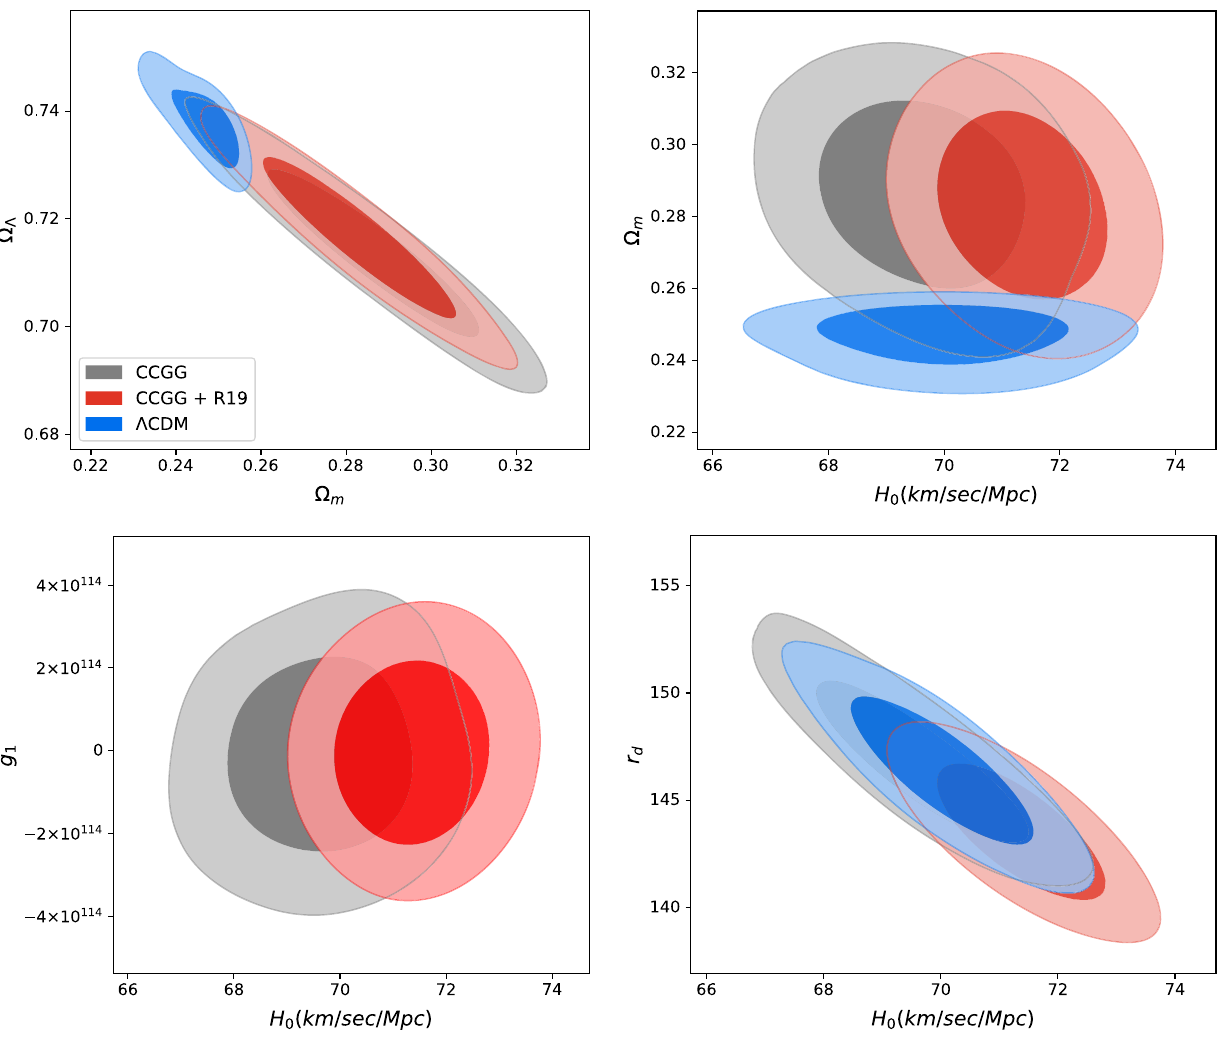
Fig. 3 One- (68% CI) and two-dimensional (68% and 95% CI) marginalized posterior distributions for the relevant sampled and derived CCGG parameters. The upper left panel shows the contour for (cid:12) m vs. (cid:12) (cid:2) and the right upper panel shows the contour for (cid:12) m vs. H 0 . The lower left panel shows the contour for g 1 vs. H 0 and the lower